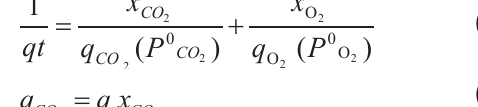
Fig. 8. The effect of acid modification in CO 2 and O 2 adsorption at 298 K.